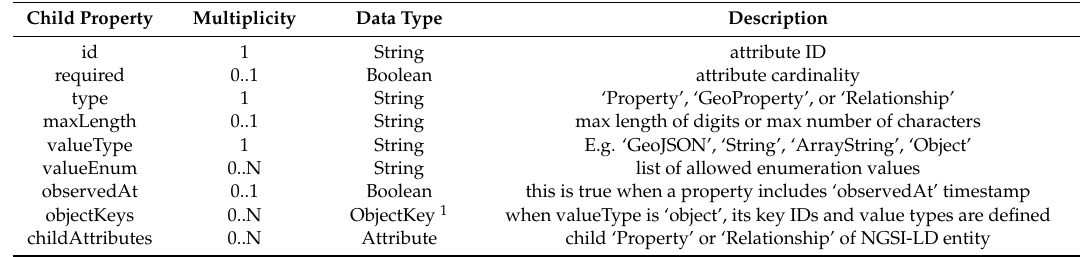
Table 2. Definition of Attribute data type.